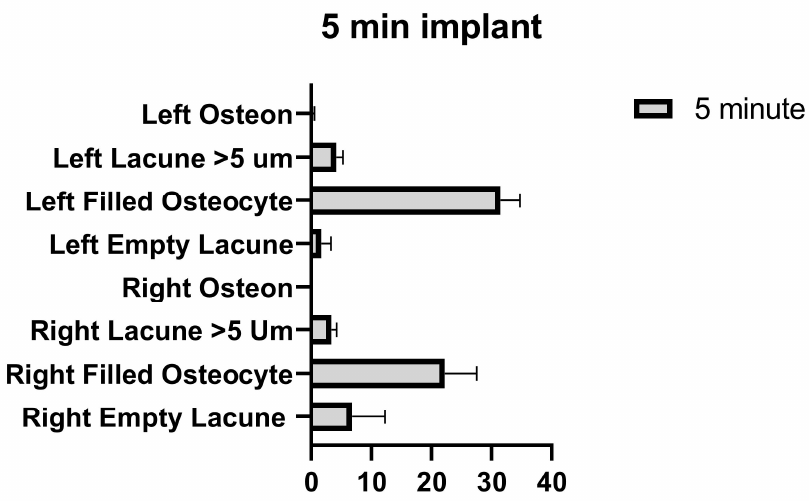
Figure 10. Left and right 2 min implant inter-group comparison graph. The number of empty lacunae in the right and left tibia was significantly different in the implants applied for 5 min. The number of osteocyte-filled lacunae was significantly different between the right and left tibia. The number of lacunae greater than 5 µ m in the right and left tibia was not significantly different. The number of osteons was significantly different between the right and left tibia (Figure 11 and Table 9).